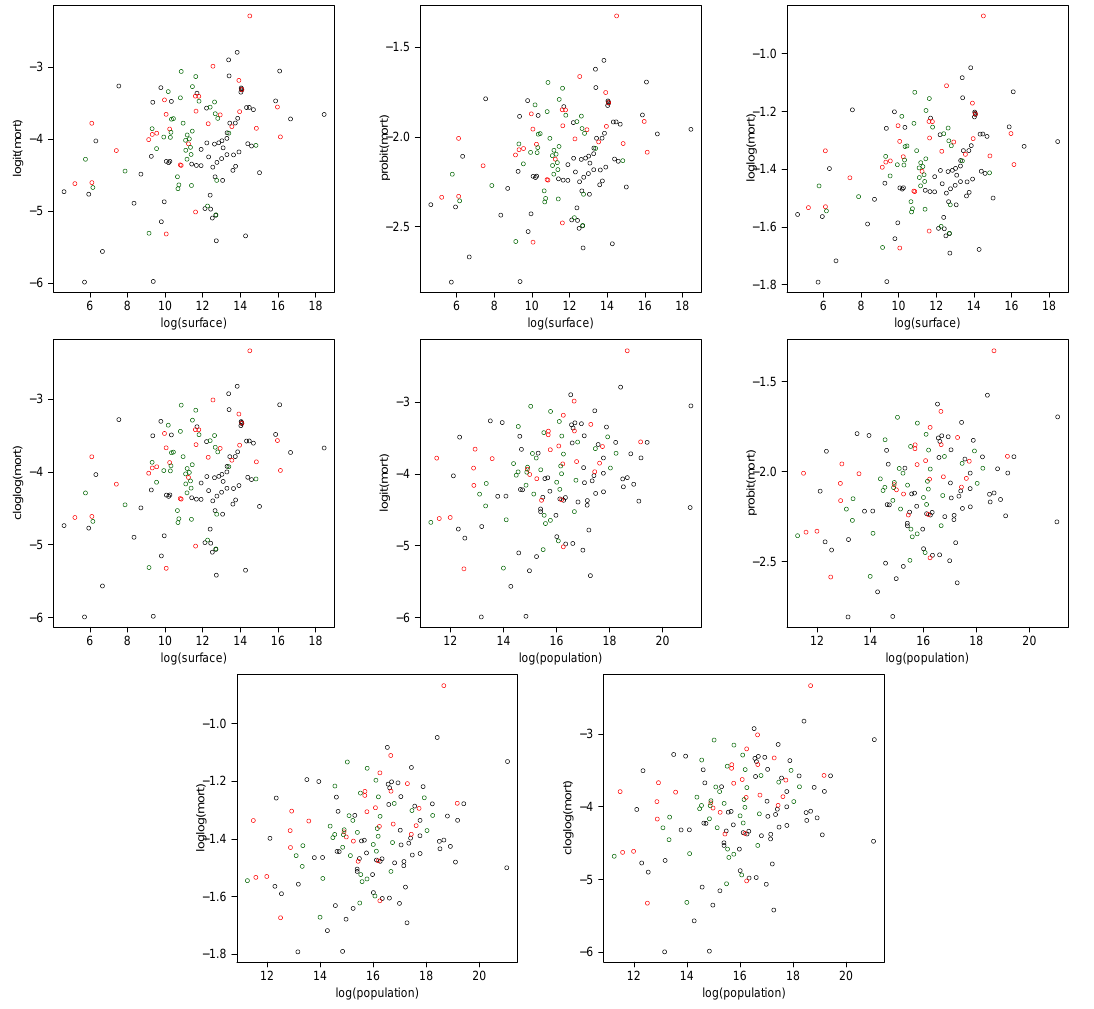
Figure 2. Descriptive plots for Q ( mort ) versus log( surface ) and versus log( population ) for different link functions: logit, probit, loglog, and cloglog and separated by continent: Africa, Asia, or Oceania (black), the Americas (red), and Europe